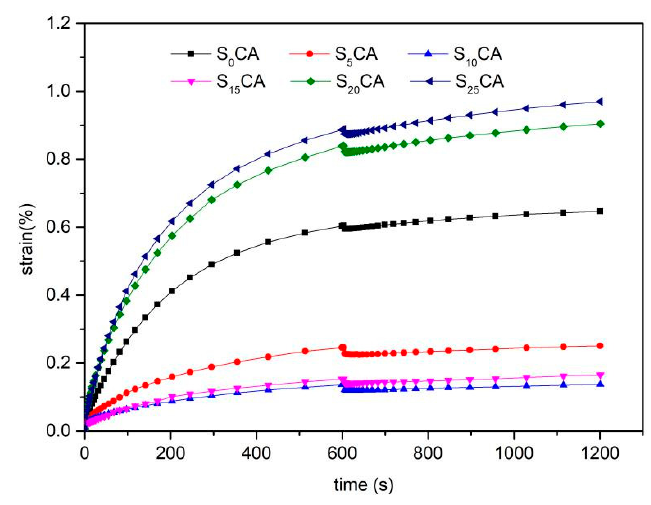
Figure 5. Creep versus time curves of the aerogels with di ff erent starch content. Table 3. The parameters of Burger’s models for the aerogels with di ff erent starch content.